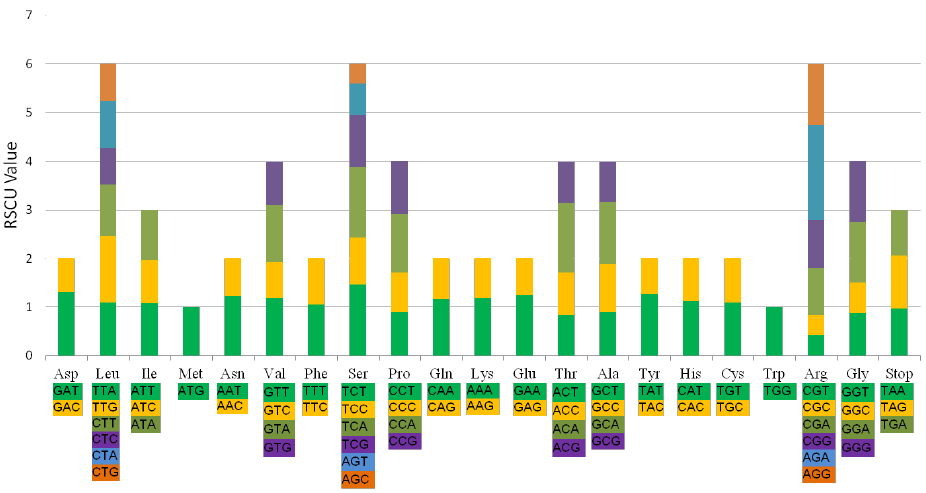
Figure 5. Codon content for 20 amino acids and stop codons in all protein-coding genes in the of L. chinense CP genome. L. chinense CP